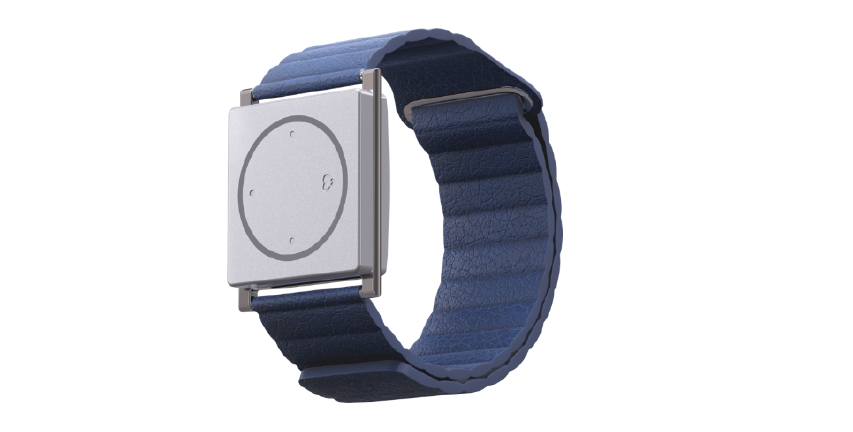
Figure 13. Embrace2 by Empatica Inc. [72] for seizure detection (Image reprinted with kind permission of Empatica